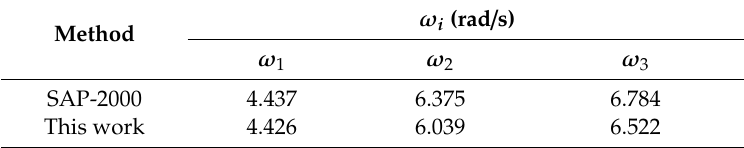
Table 8. Variation of the first natural frequencies of the space frame system as a function of m T / m 0